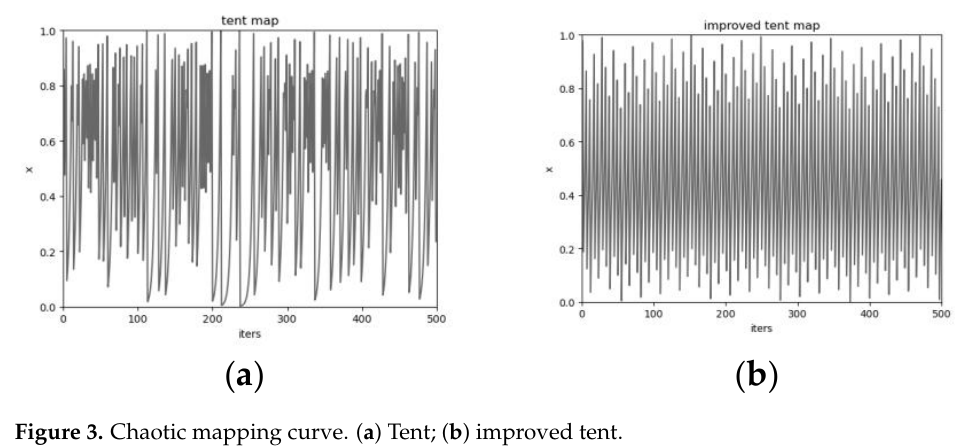
Figure 3. Chaotic mapping curve. ( a ) Tent; ( b ) improved tent. Finally, map it to the grey Wolf Pack search